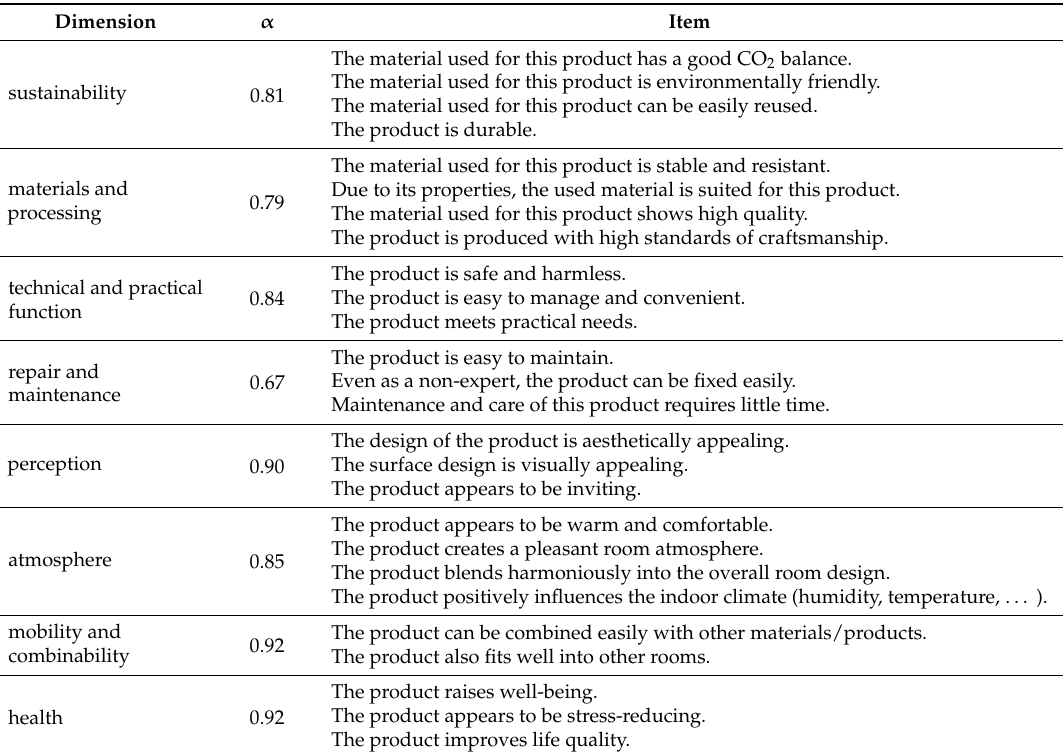
Table A1. Items, dimensions and Cronbach’s Alpha of the